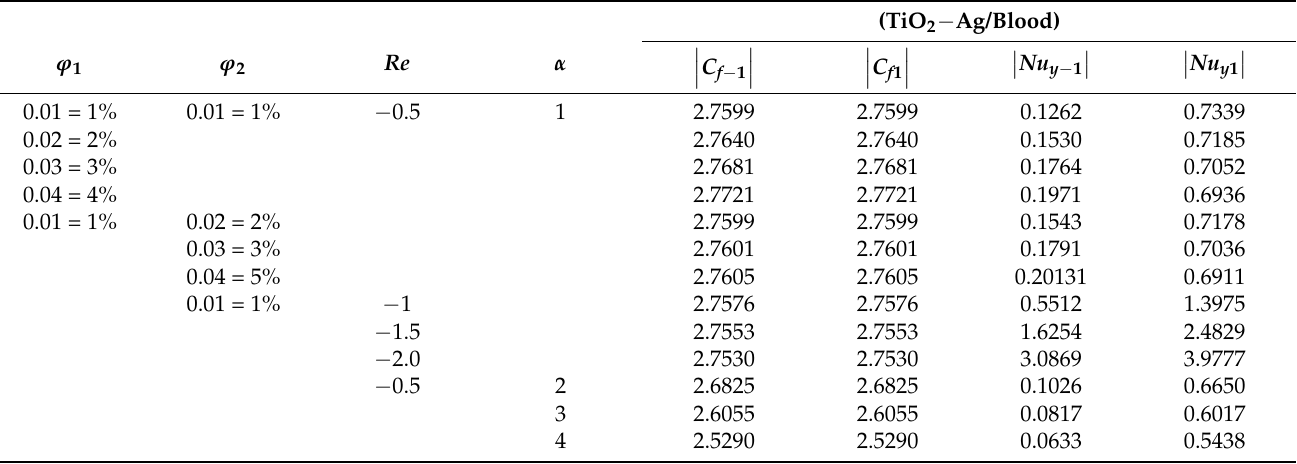
Table 5. Skin fraction and Nusselt number results on volume fraction, Reynolds number,